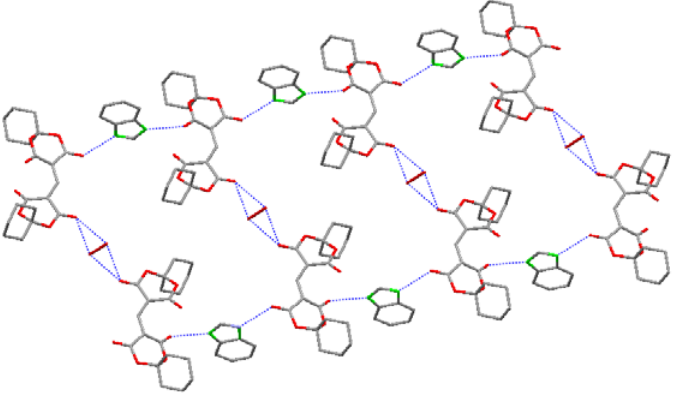
Figure 3. One-dimensional (1D)-chained structure by N–H ··· O and O–H ··· O intermolecular interactions.